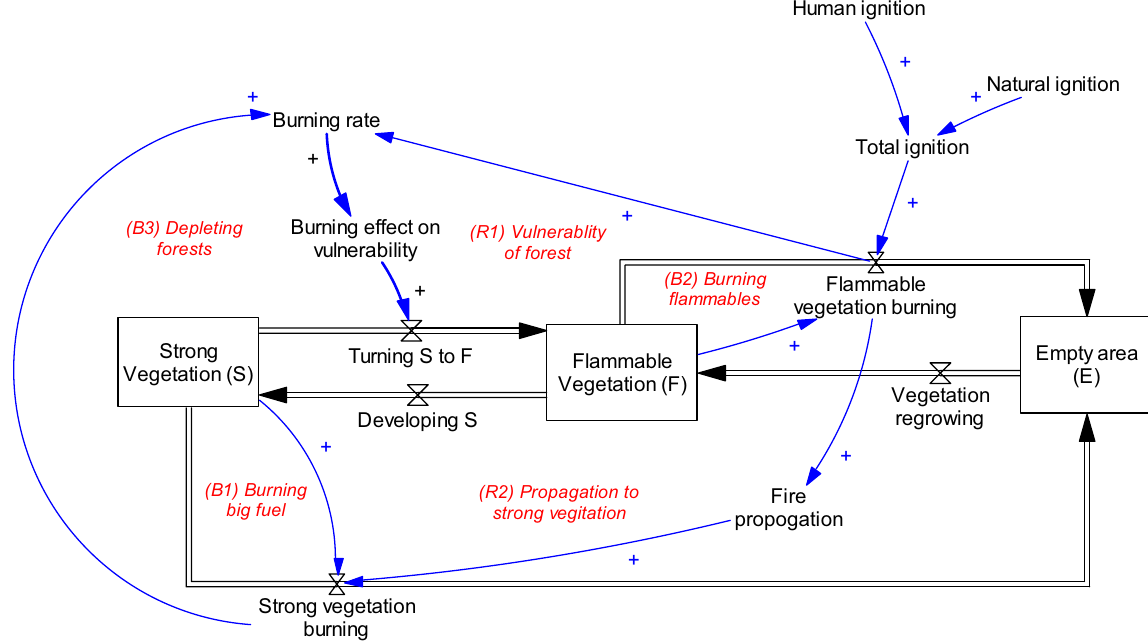
Figure 3. A stock-flow diagram of vegetation. Note: Sock variables represent the state of the system and are shown in boxes (strong vegetation, flammable vegetation, and empty area), and flows, representing change in state variables are depicted by valve signs. Causal influences are shown with blue links, where a plus sign in X → + Y indicates that X and Y move in the same direction ( X → + Y ⇔ ∂ Y causal arrow indicates that the variables move in the opposite direction ( X → − Y ⇔ ∂ Y information on causal loop diagrams, see Sterman 44